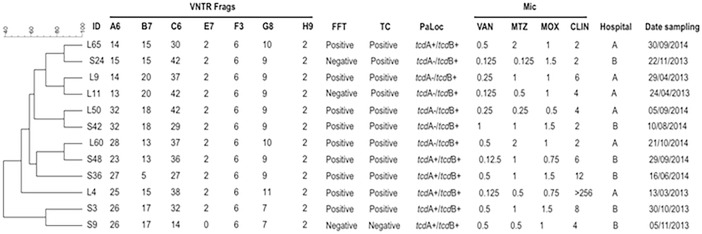
Analysis of ribotype 106 by MLVA.MLVA was applied to 12 isolates belonging to the ribotype 106. Dendrogram showing similarities of banding patterns generated with high-resolution capillary gel-based electrophoresis (CE)-PCR. MLVA clusters are identified by minimum-spanning tree: one clonal complex is defined by MLVA type with less than a two-locus difference. In addition, free fecal toxin A/B (FFT), toxin in cell culture (TC), presence of PaLoc genes (tcdA/tcdB), minimal inhibitory concentrations (MIC) for vancomycin (VAN), metronidazole (MTZ), moxifloxacin (MOX) and clindamycin (CLIN) are shown for each isolate with the respective breakpoints. VNTR, variable-number tandem repeat.